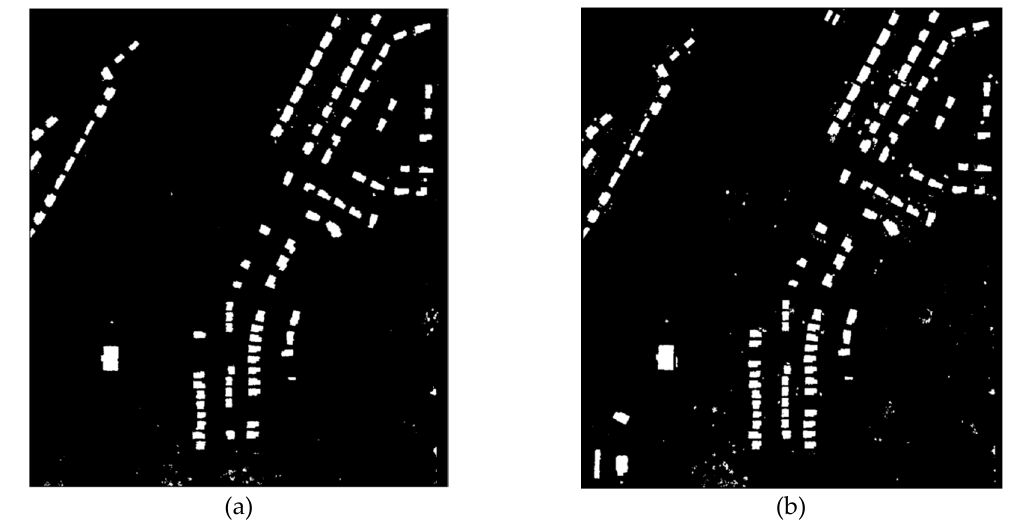
Figure 7. Output of the applying threshold on nDSM. ( a ) first data; ( b ) second data.